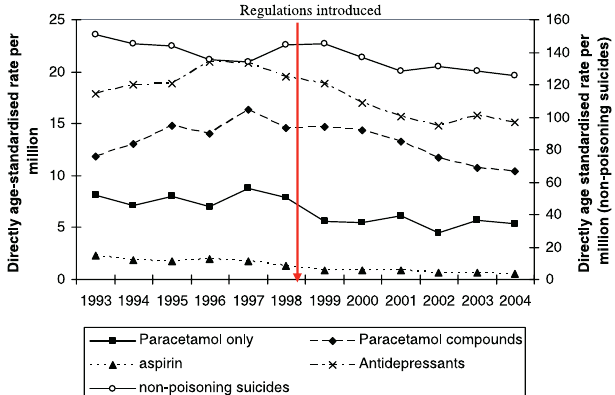
Figure 1. Directly Age-Standardised Mortality Rates per Million, England and Wales, 1993–2004